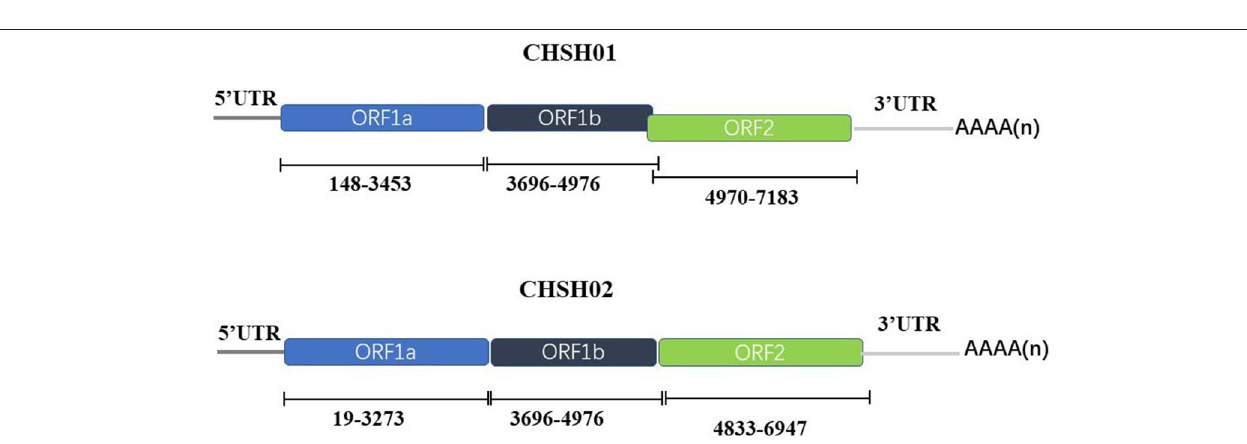
About 200 µ l of the filtrate was inoculated into allantoic cavities of 10 10-day-old goose embryos by aseptic technique. The embryos were incubated at 37 ◦ C for 7 days, and the embryos that died during the first 24 h were